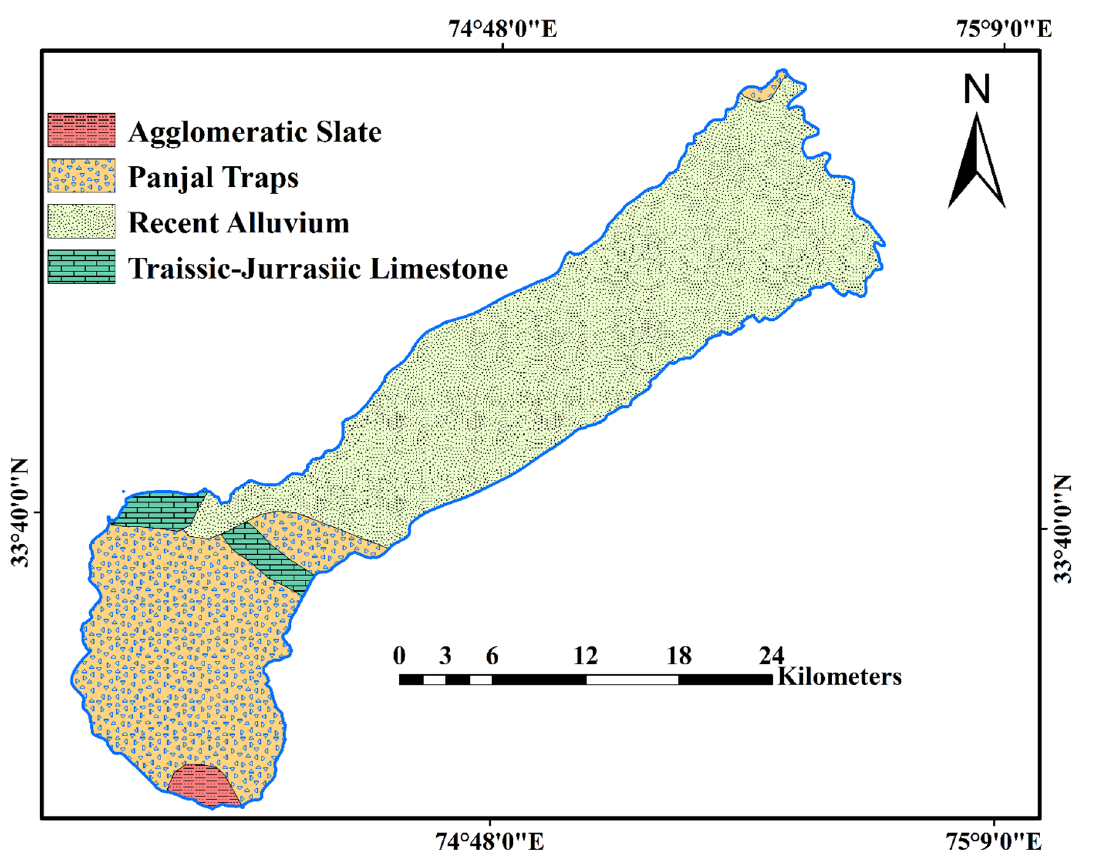
Fig. 4 Lithological map of study area. Modified after Thakur and Rawat